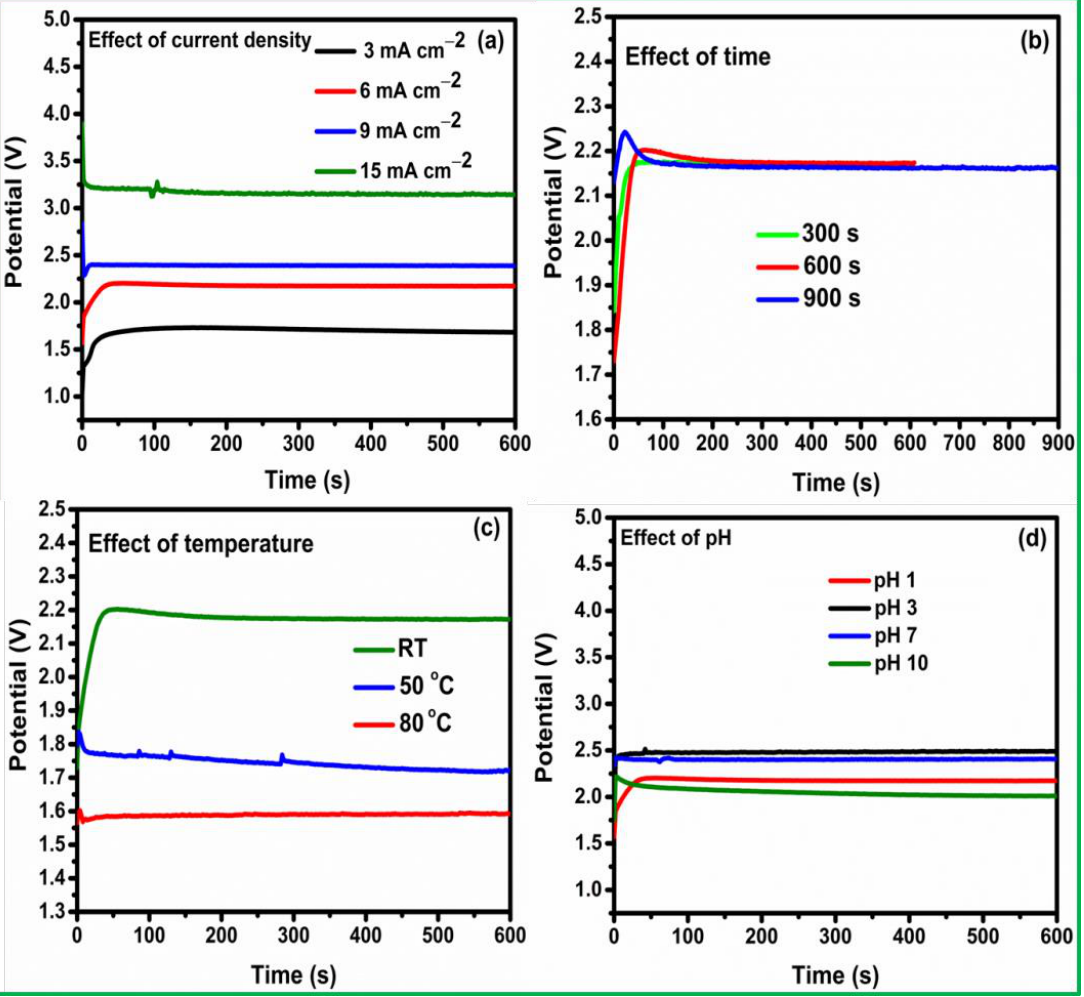
Figure 6. Pt deposition on a carbon surface via the ( a ) effect of current density, ( b ) effect of time (constant current density), ( c ) effect of temperature, and ( d ) effect of pH with constant current density (6 mA cm −2 ).